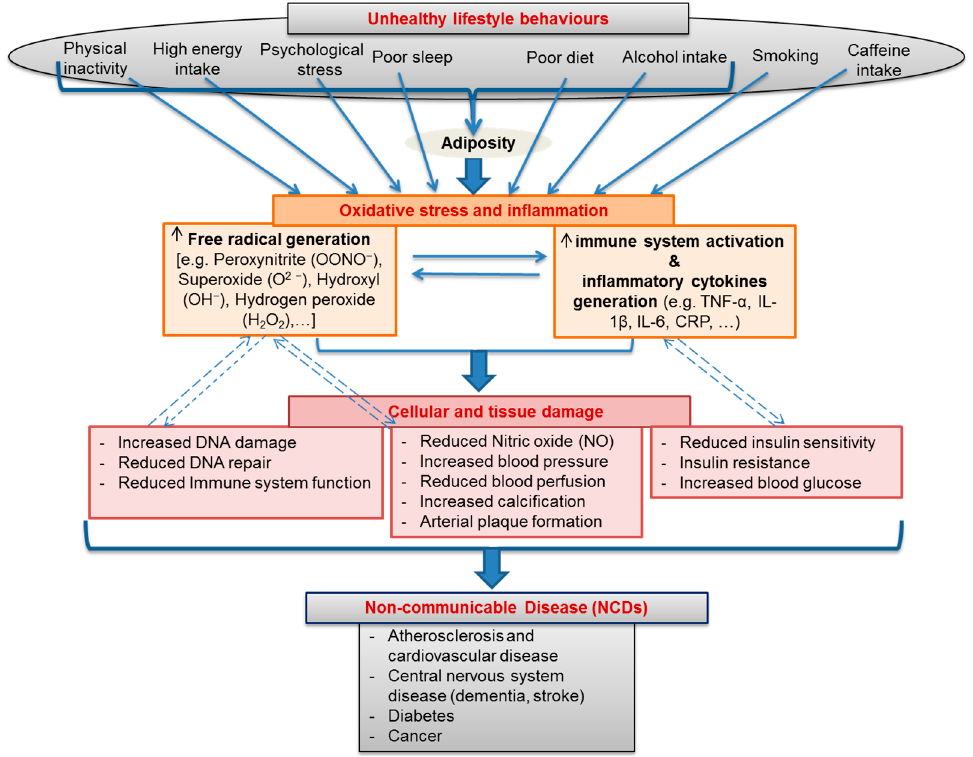
Figure 2. A schematic showing lifestyle behaviours as major drivers behind the development of an oxidative stressed and inflammatory state which in turn play primary roles in the chronic cellular and tissue damage that leads to the final development of multiple non-communicable diseases (NCDs).